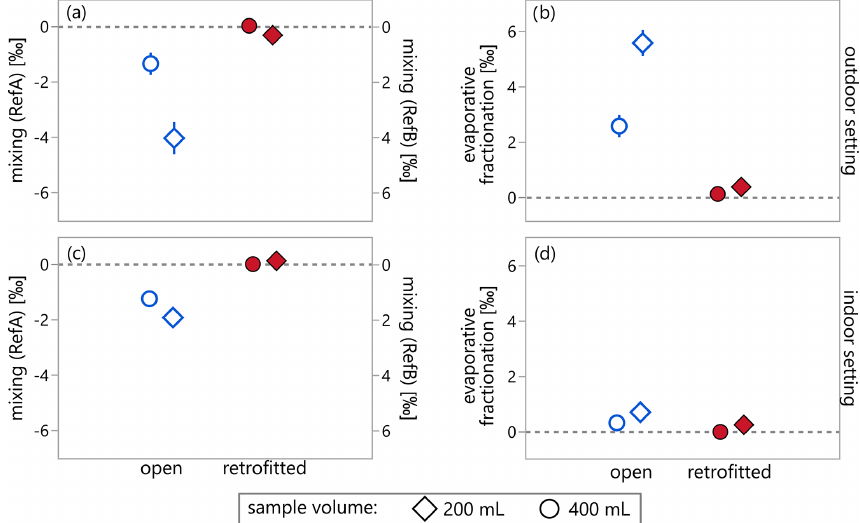
Figure 5. A comparison of the isotope effects due to mixing (a, c) and evaporative fractionation (b, d) in water samples stored outdoors (a, b) and indoors (c, d) during Experiment 2. Both mixing and evaporative fractionation effects are small in samples from the retrofitted bottles (filled red markers) and larger in samples from the open bottles (open blue markers). In addition, the isotope effects were larger for the 200mL samples (diamonds) than for the 400mL samples (circles). Error bars indicate standard errors determined from the three replicates of each combination of the two reference waters (RefA vs. RefB), the two sample volumes (200mL vs. 400mL), and two bottle types (open vs. retrofitted with evaporation protection), and they account for measurement uncertainty and the standard error of the sample